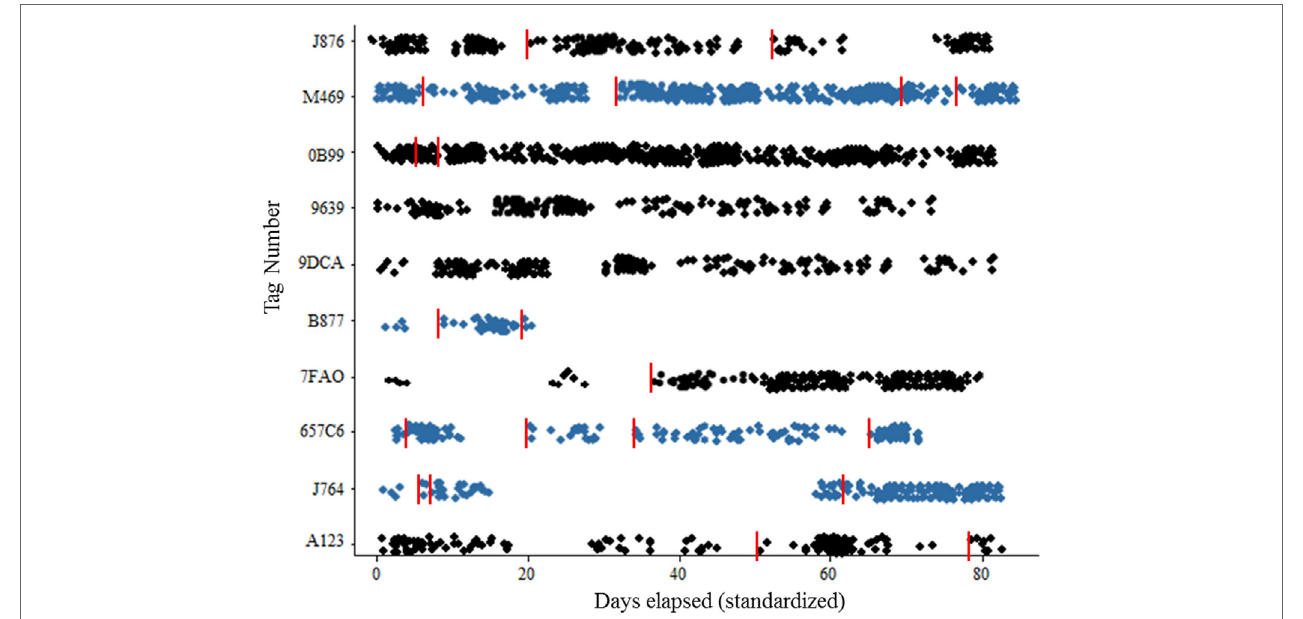
FIGUrE 3 | scatterplot of recruitment for wild Norway rats, Rattus norvegicus to sensor by sex . Females represented by blue color, recaptures are indicated with vertical red line. Target population should be 20 animals × 7 sites = 140 marked